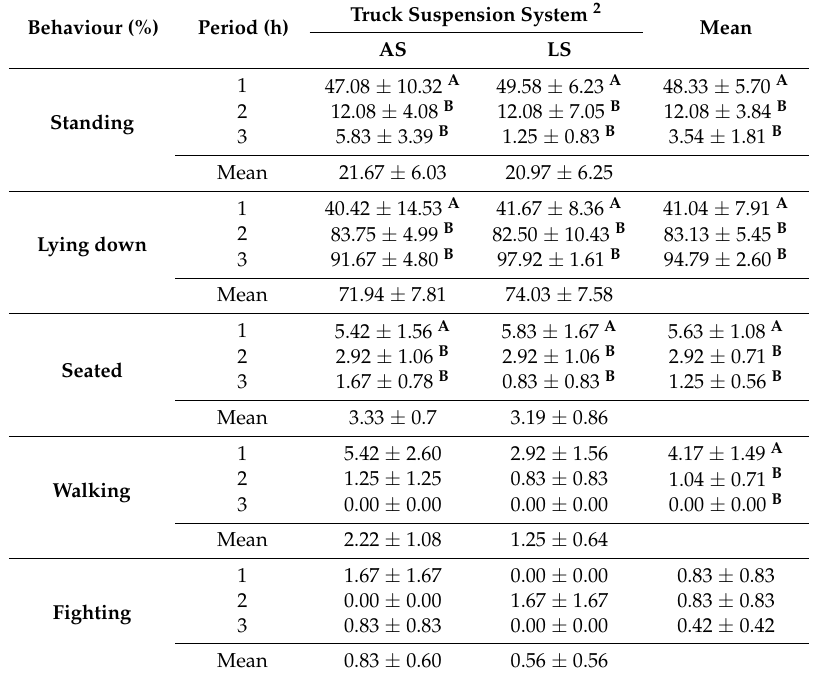
Table 3. Effects of truck suspension system on behavior 1 of pigs during